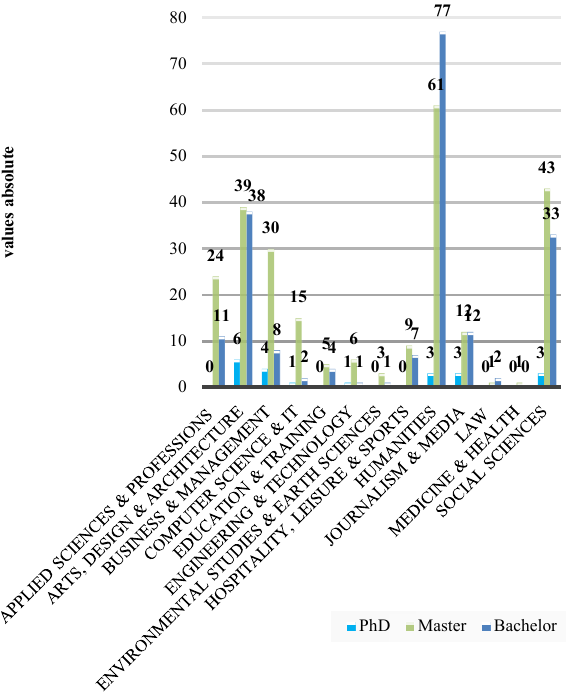
Figure 3. Levels and disciplines of DCH studies in Europe